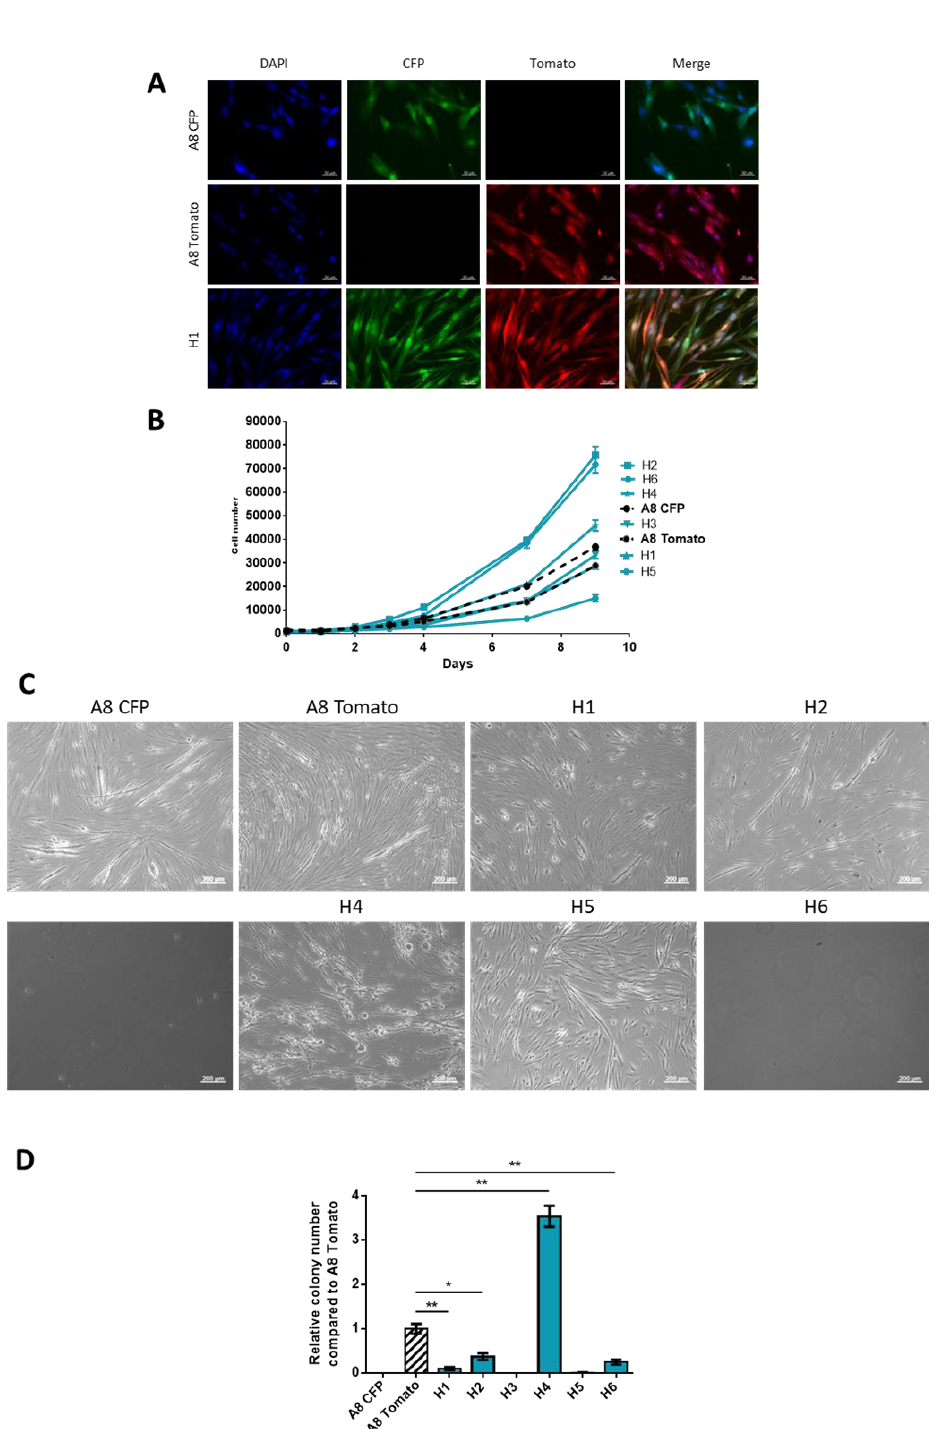
Figure 1. Validation of hybrids obtained by spontaneous cell fusion and phenotypic characterization. ( A ) Fluorescence expression of parental cell lines and H1. Scale bar = 50 µ m. ( B ) Proliferation assay. Viable cell number was determined by flow cytometry from day 0 to day 9. Graph shows one representative experiment with triplicates for each cell line. This experiment was performed three times. ( C ) Evaluation of capacity to form myotubes. Images taken in phase contrast. Scale bar = 200 µ m. ( D ) Capacity to form colony in soft agar (non-adherent conditions). Histogram shows one representative experiment with triplicates for each cell line. Experiment was performed three times. * p -value < 0.05; ** p -value < 0.01 Mann-Whitney